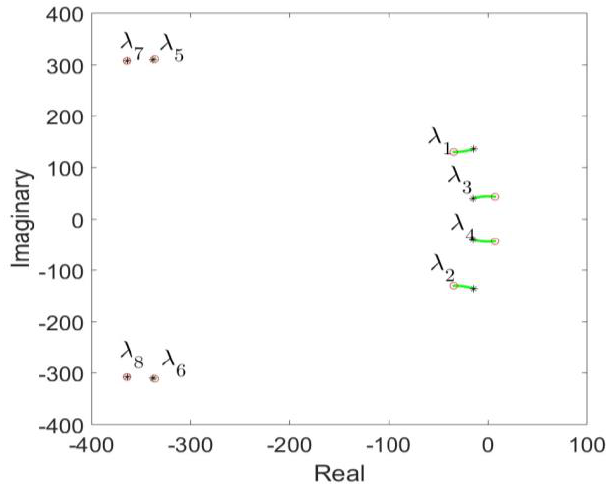
Figure 13. Eigenvalue loci of closed-loop system with k ppll from 1 to 3.